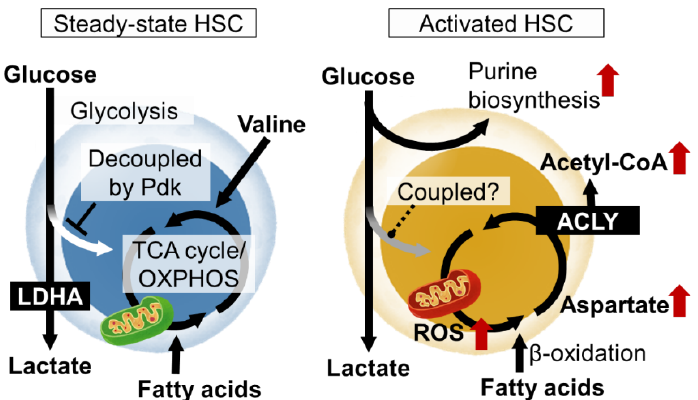
Figure 1. Nutrient requirements and metabolic programs of hematopoietic stem cells (HSCs) in steady state and upon activation. In steady-state HSCs, glycolytic and mitochondrial ATP production are decoupled. Various metabolic pathways are activated in HSCs upon stress loading or cytokine stimulation, resulting in metabolic reprogramming that induces proliferation and differentiation. LDHA, lactate dehydrogenase A; ROS, reactive oxygen species; Pdk, pyruvate dehydrogenase kinase; TCA, tricarboxylic acid; OXPHOS, oxidative phosphorylation; ACLY, ATP citrate lyase.